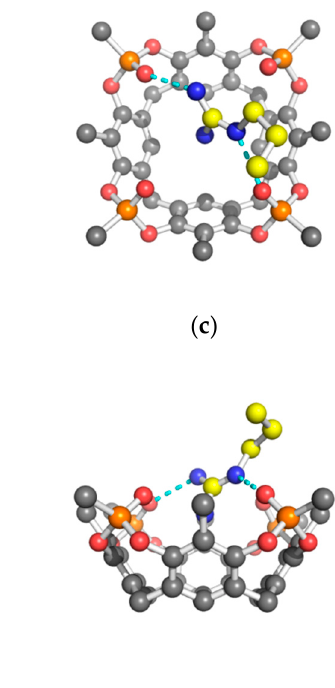
Figure 2. Orthogonal views of the H-bond interactions (cyan dashed lines) between the side chain of Arg amino acid (yellow carbons) and tetraphosphonate cavitand Tiiii (grey carbons) ( a , b ) conformation I; ( c , d ) conformation II. Other atoms color code: P, orange; N, blue; O, red. Hydrogen atoms have been omitted for clarity.